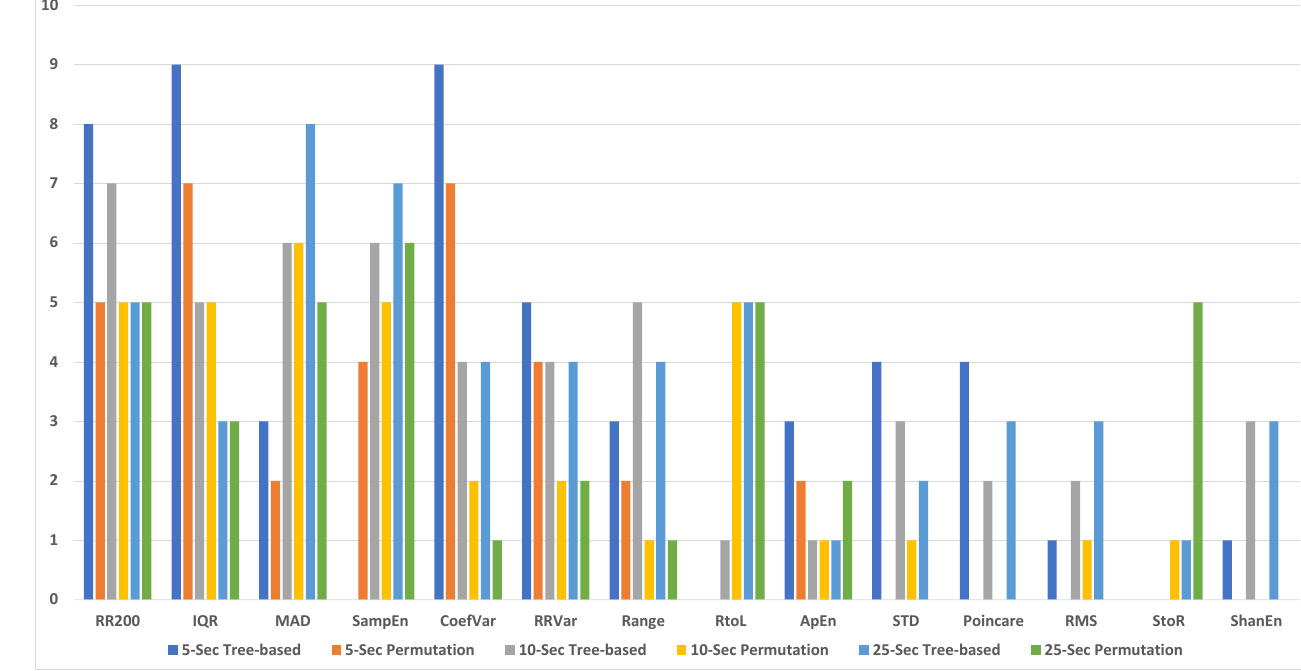
Figure 16. Top five features for all models with 5-, 10-, and 25-s segmentation